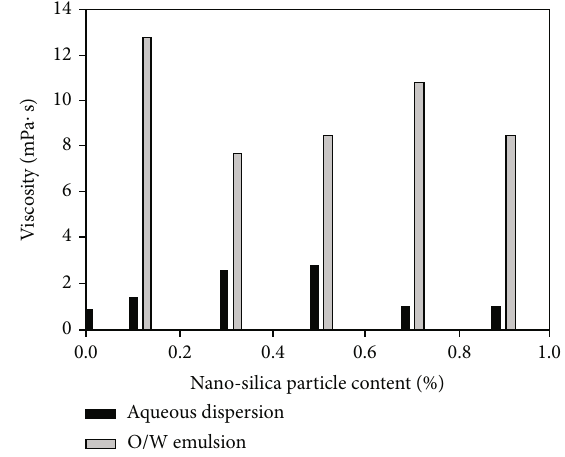
Figure 8: Viscosity comparison between aqueous dispersion and O/W